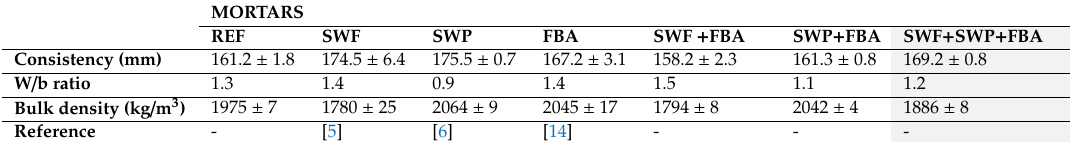
Table 1. Fresh state tests